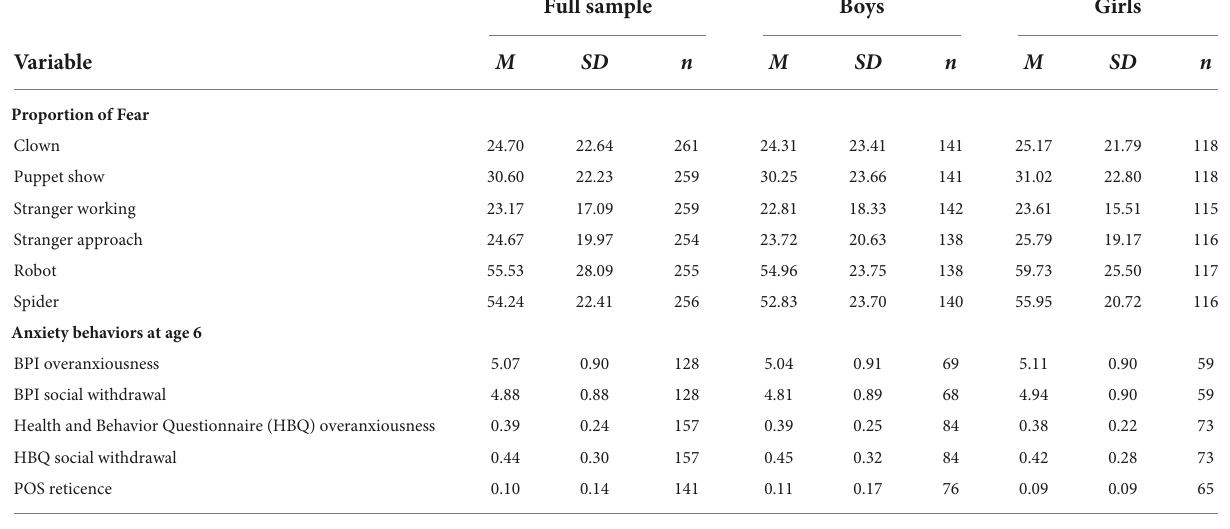
TABLE 1 Means and standard deviations of key variables of interest by child gender.